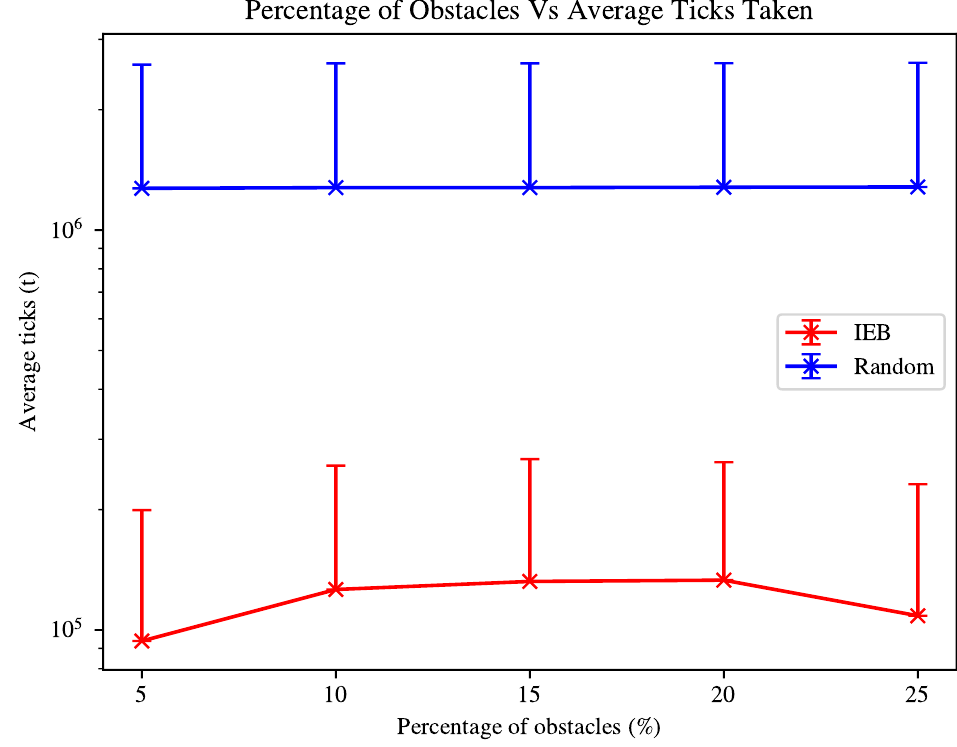
Figure 3. Time taken to find a single transmitter within an environment with an increasing number of randomly placed obstacles, where average time is shown. Error bar indicates σ 2 standard